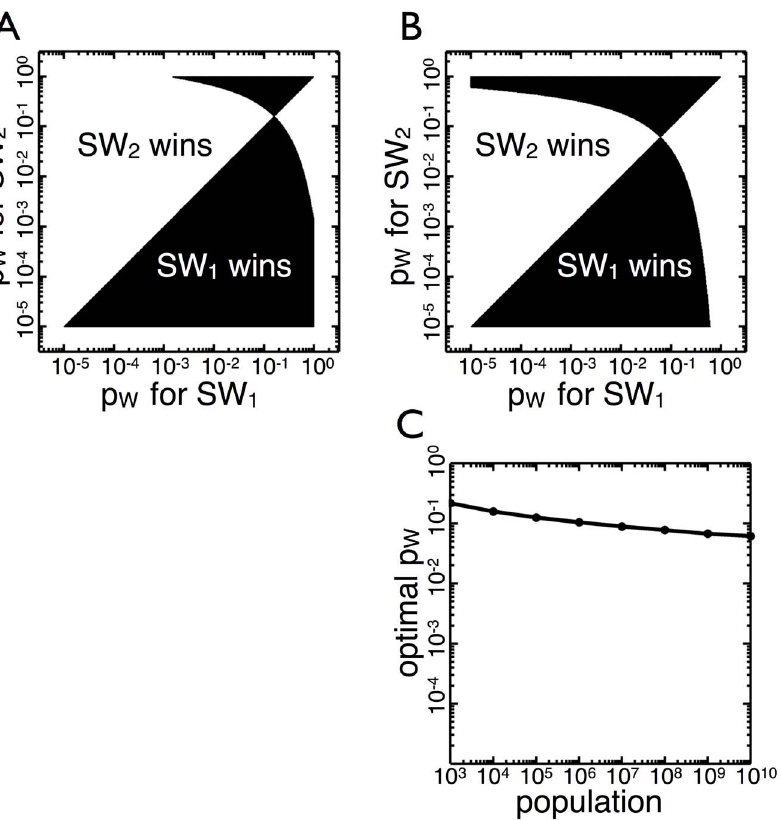
Figure 2. Competition between SW genotypes with different transition probabilities, p w . (A) The black area corresponds to specific combination of p w values for two SW genotypes in which SW 1 leaves more W types than SW 2 when the environmental state changes to E W at N ~ 10 4 . The white area represents the converse. There is an optimal p w ( & 10 { 0 : 80 ) which results in more W types compared to any other p w . (B) The same as A but with N ~ 10 10 . The optimal p w has decreased to & 10 { 1 : 20 . (C) The optimal p w is calculated for N values between 10 3 and 10 10 . As N increases over seven orders of magnitude, p w remains relatively constant, decreasing less than an order of magnitude.